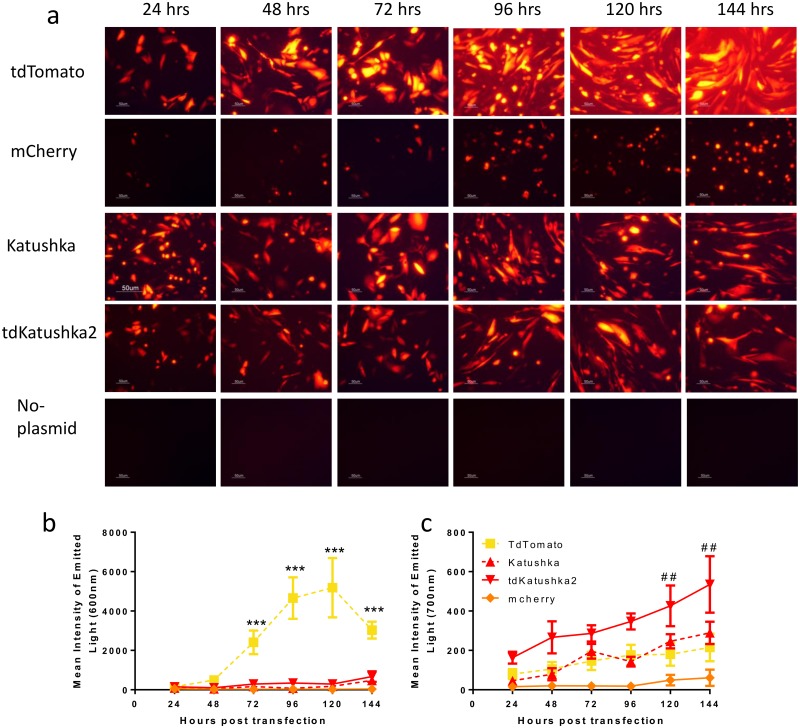
Comparison of red fluorescent proteins in vitro.CHO-k1 cells were transfected with 1μg DNA complexed with Lipofectamine. At various time points, cells were imaged by fluorescent microscopy—excitation 540–580nm and emission 600–660nm (a). Fluorescence intensity was measured by image analysis software at 550–600 nm (b) or 600–700 nm (c). Images in (a) representative of n = 3 experiments, points in b and c represent mean +/- SEM of 4 repeats, *** p<0.001 comparing tdTomato and other proteins in panel b, ## p<0.01 comparing tdKatushka2 and other proteins in panel c, by 2 way ANOVA.